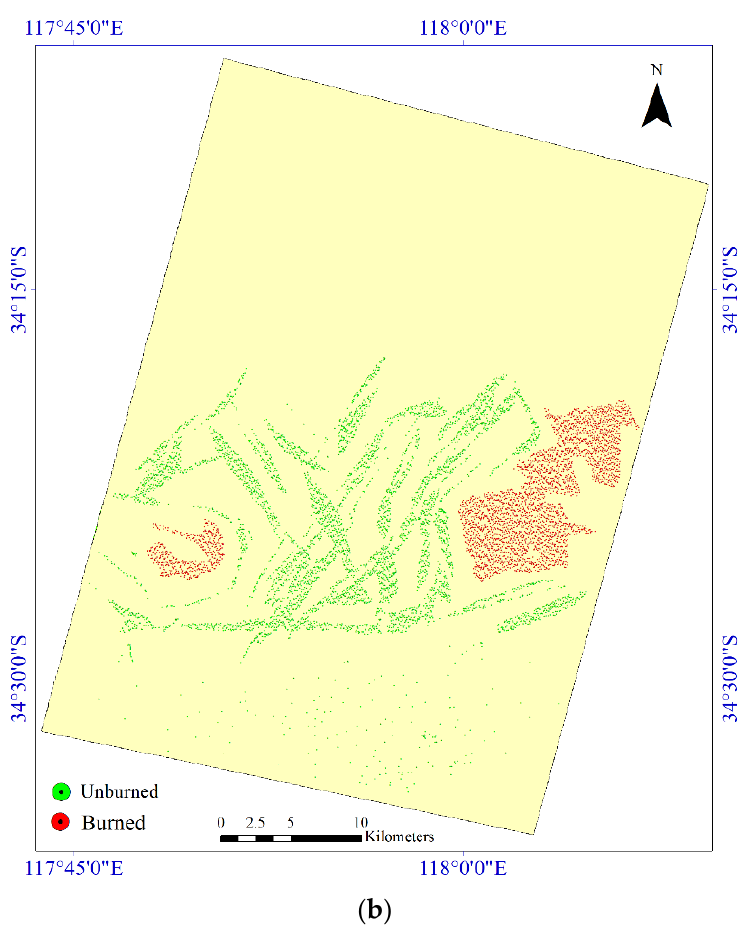
Figure 6. The spatial distributions of the two study areas for the burned area mapping. ( a ) Sample data for the first study area. ( b ) Sample data for the second study area.